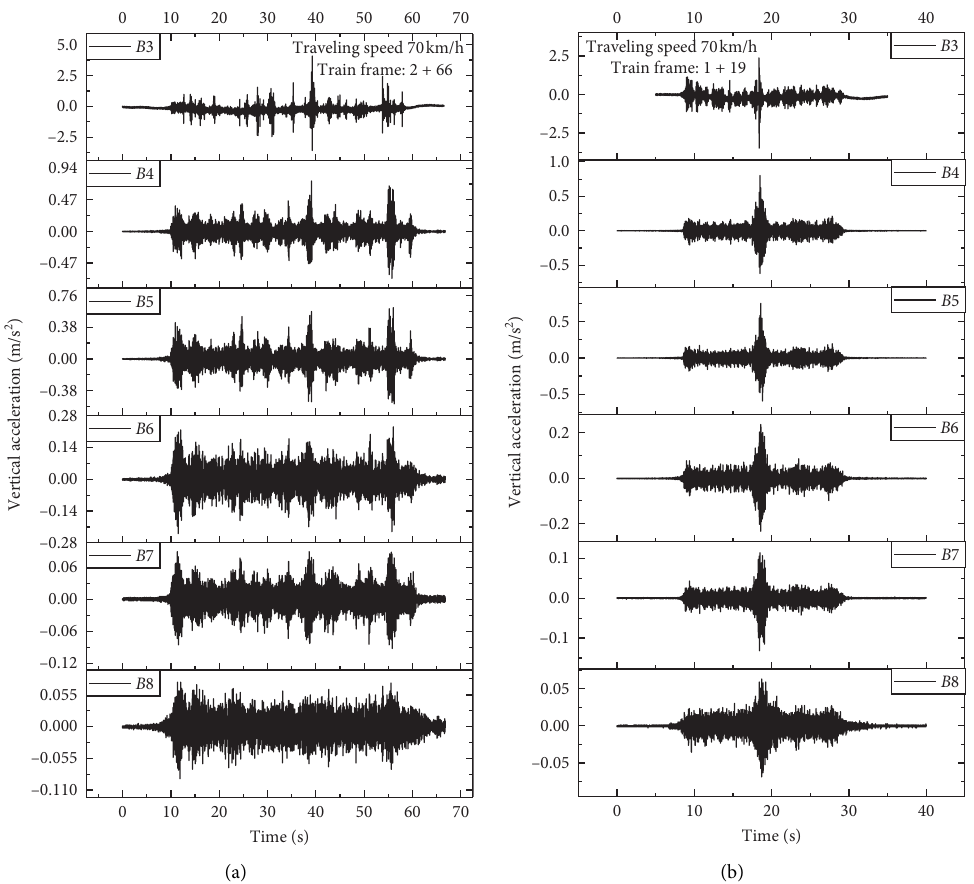
Figure 3: Acceleration time-history curves: (a) freight train 3; (b) passenger train 1548.